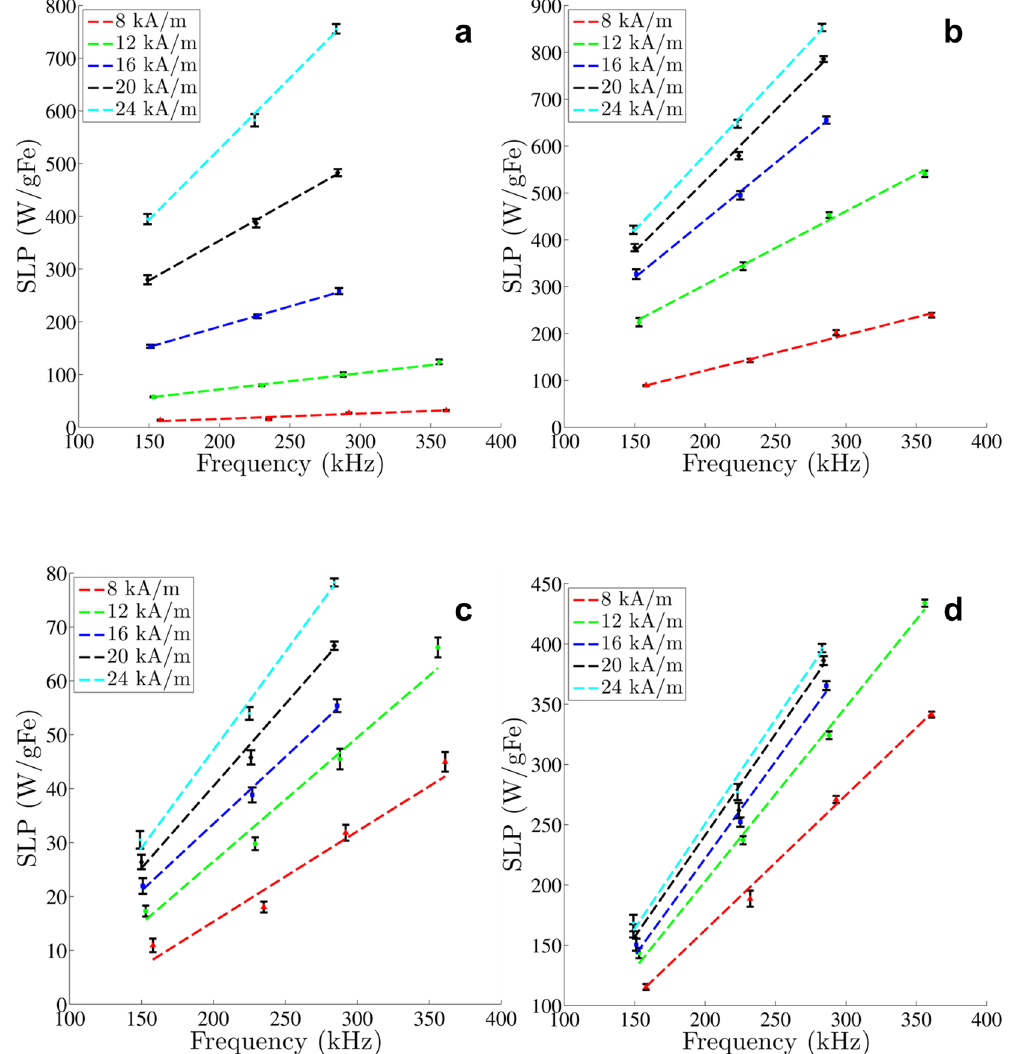
Figure 4. Specific loss power (SLP) measurements versus frequency of four different magnetic nanoparticle solutions ( a : BNF Dextran, b : JHU, c : nanomag ® -D-spio, d : MnFe 2 O 4 ) at five different field strengths ranging from 8 kA/m to 24 kA/m, in increments of 4 kA/m. Data shown represent the average SLP value with the standard deviation as error